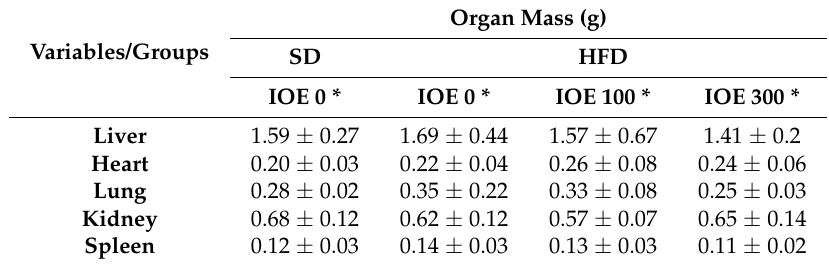
* (mg/kg/day). Data are expressed as mean ± standard deviations (S.D) ( n = 6). HFD, high fat diet. IOE, Ishige okamurae extract.